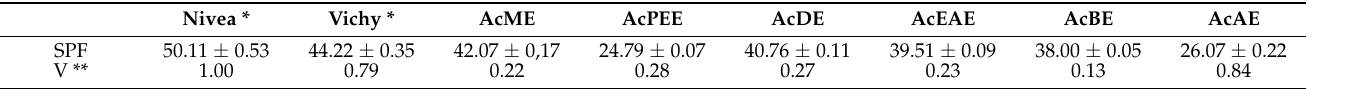
Table 7. Photoprotective activity of different extract/fractions of A. campestris